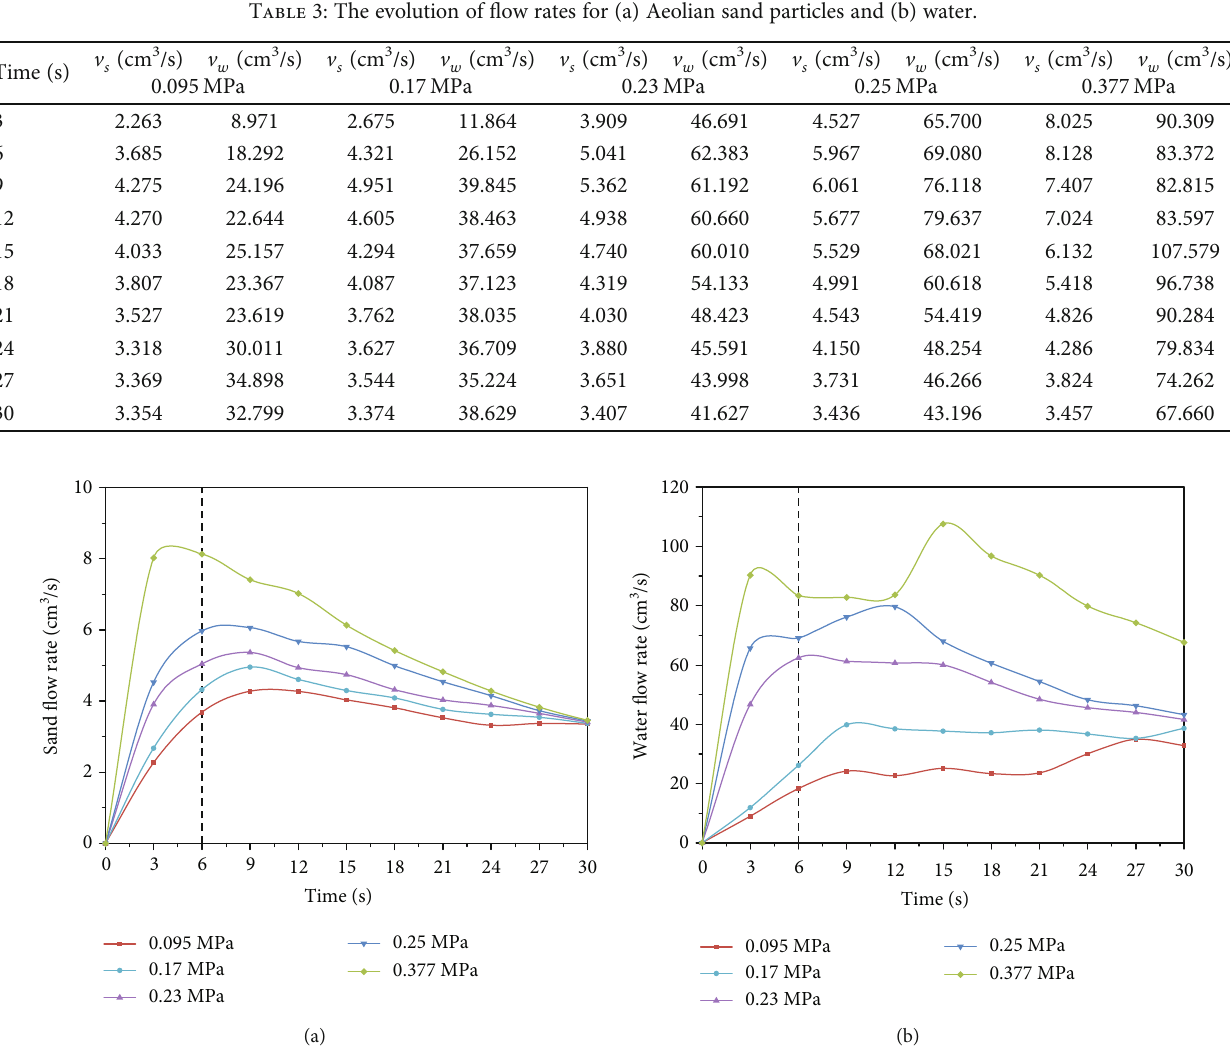
Figure 11: The evolution in (a) sand fl ow rates and (b) water fl ow rates with time for di ff erent water pressure. Table 4: The porosity and porosity change rate